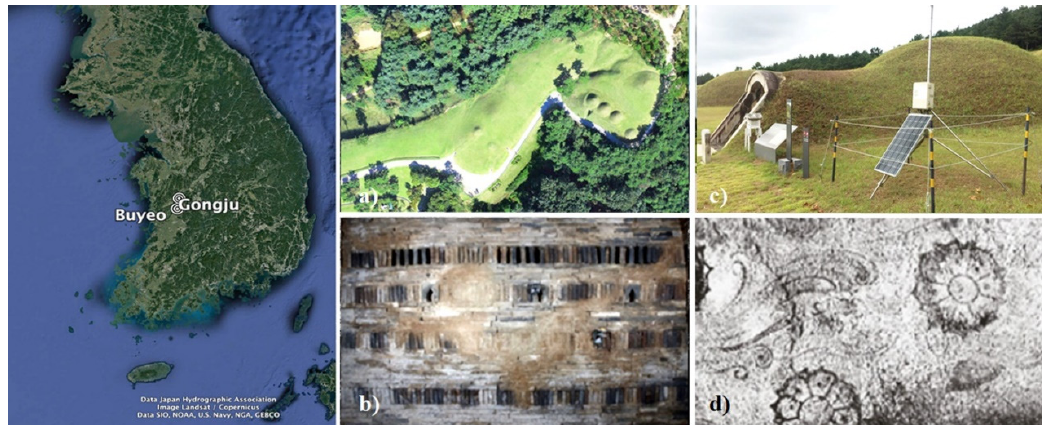
Figure 2. Location of South Korean study cases and details of the UNESCO World Heritage sites of